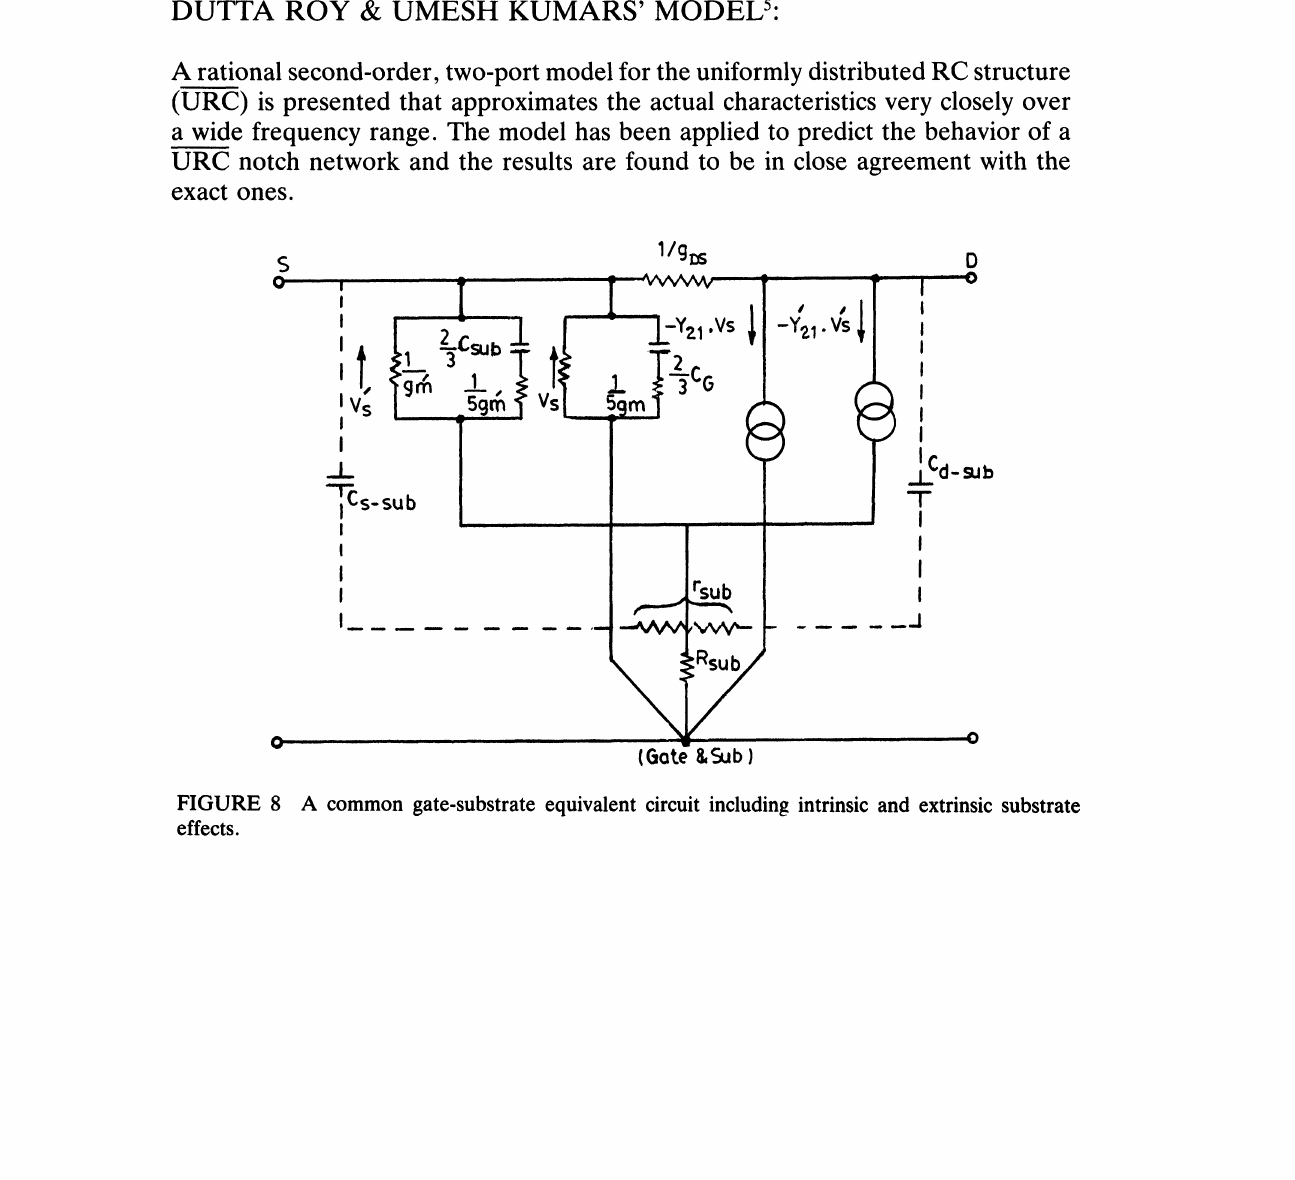
FIGURE 7 A idealised common gate-substrate equivalent circuit in absence of substrate spreading resistance.